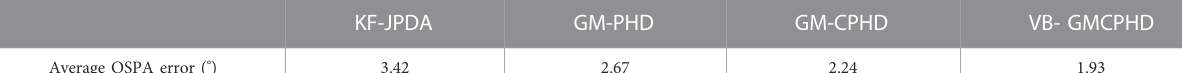
TABLE 1 The average OSPA errors of the tracking results of KF-JPDA, GM-PHD fi lter, GM-CPHD fi lter, and VB- GMCPHD fi lter in one tracking step.